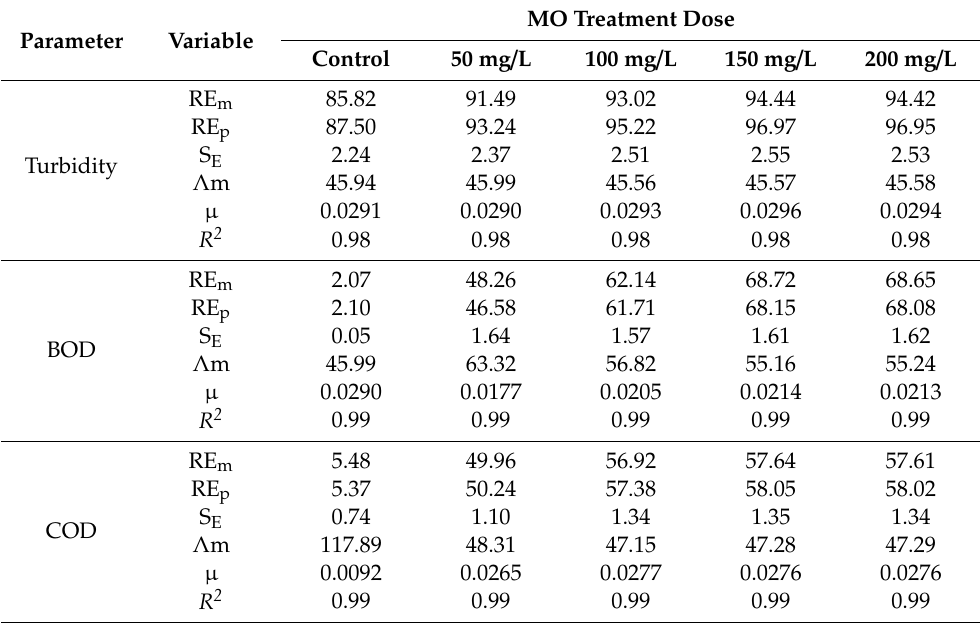
Table 3. Measured versus predicted percent (%) removal of turbidity, BOD, and COD with Gomphertz model